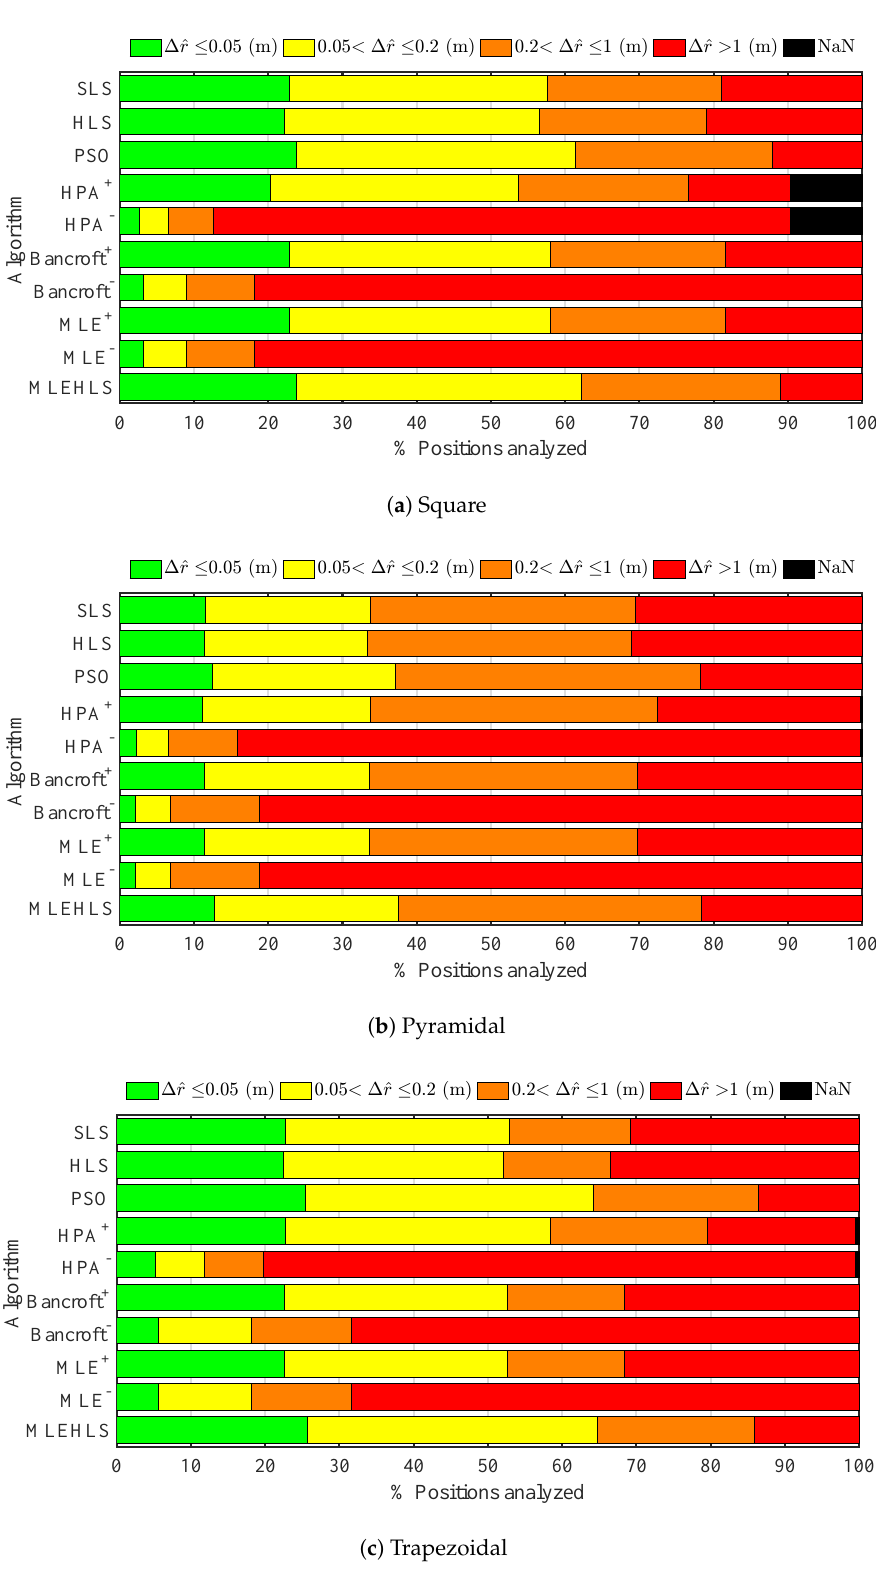
Figure 8. Percentage of positions located within the errors in the radius ∆ ˆ r defined in the legend under digitizing error in time variables for each algorithm and antenna array